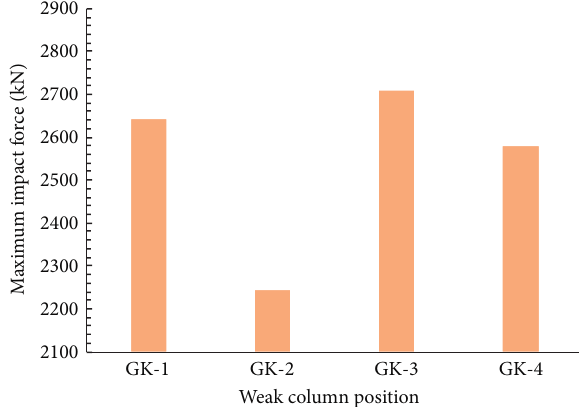
Figure 10: Maximum impact force at different weak column positions (PGA � 0.62g).